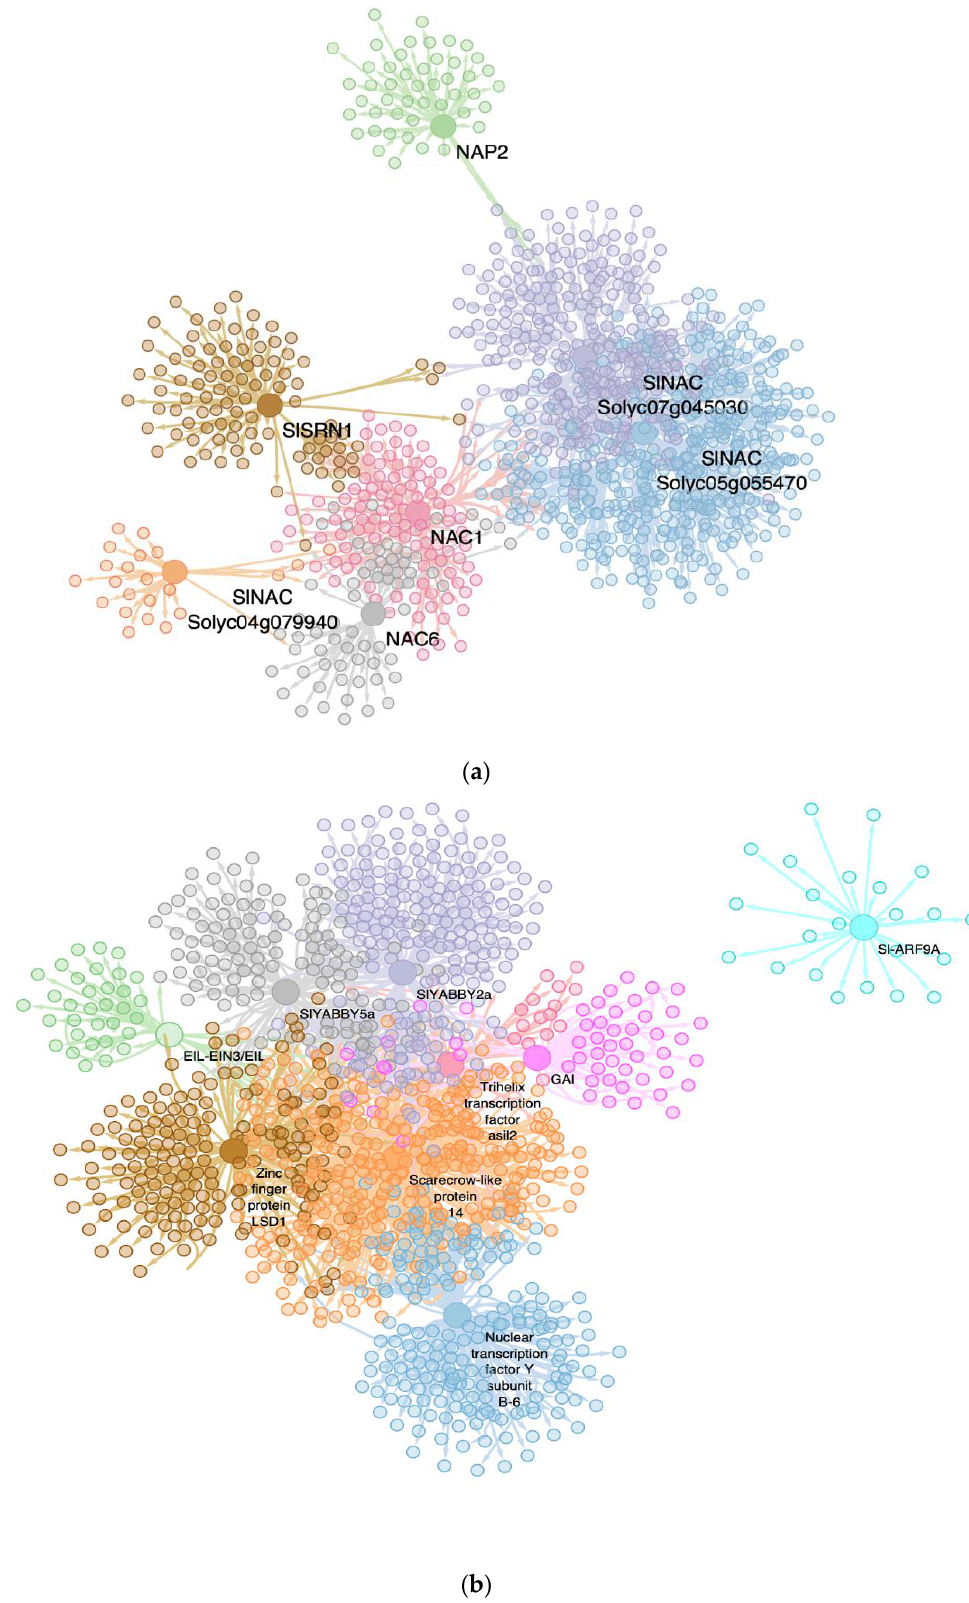
Figure 7. Interactomes of the C. vs. S23 conditions in leaf tissue-specific samples. Each node represents a gene, and the edges between nodes represent regulatory interactions between genes. The big, highlighted nodes with a specific color represent MTRs, while nodes of the same color surrounding these represent target genes regulated by them. ( a ): NAC family MTRs in tissue-